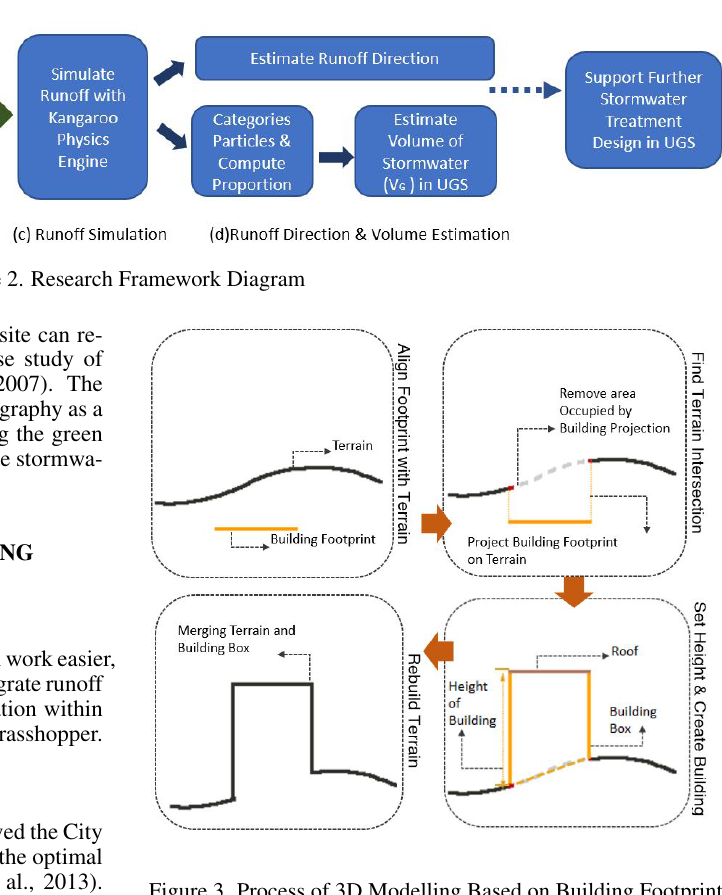
Figure 3. Process of 3D Modelling Based on Building Footprint and Terrain